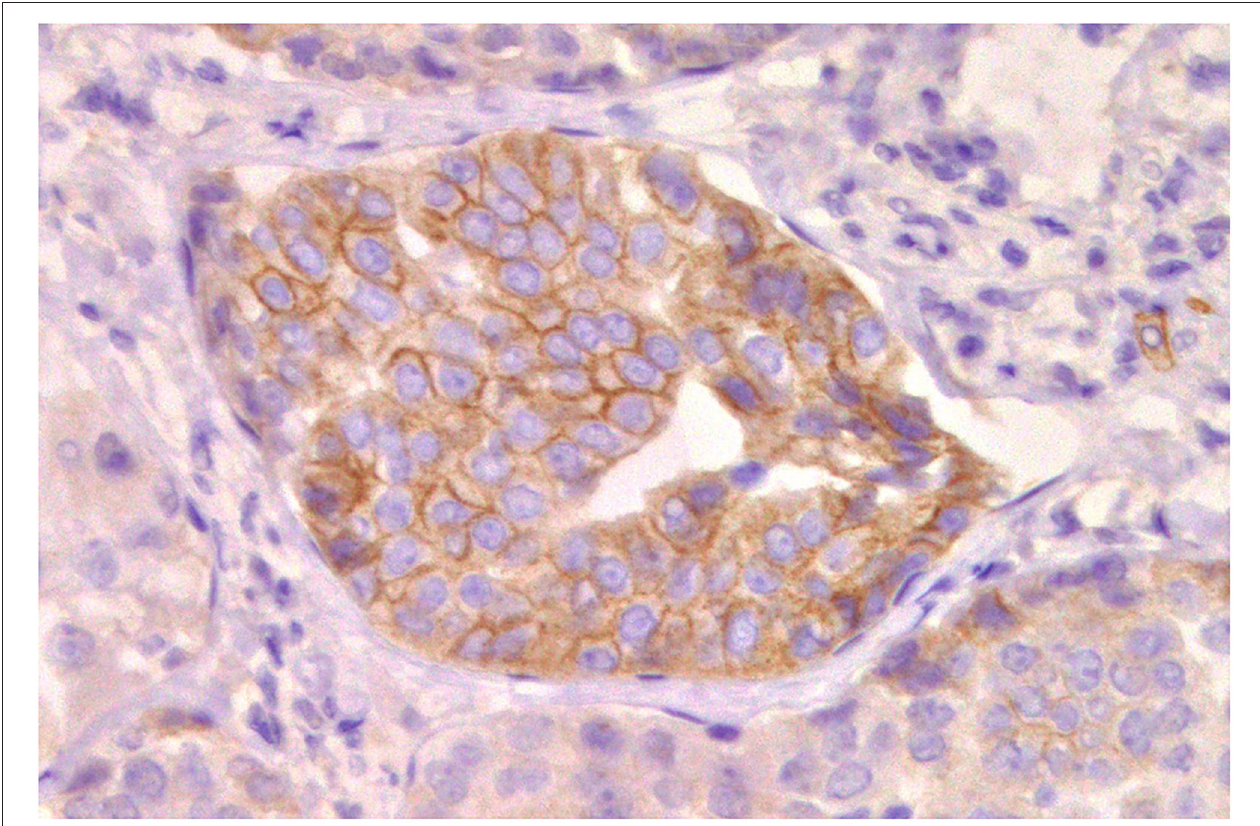
FIGURE 10 | Tubular carcinoma, mammary gland, dog. Immunohistochemical membranous staining of stem cell factor receptor (c-KitR). Neoplastic cells are